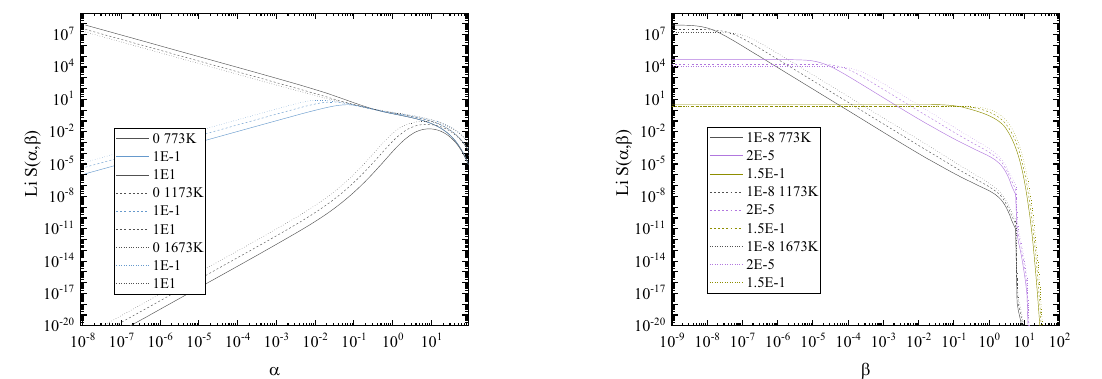
Figure 7 . TSL v. α (left, for various β values) and TSL v. β (right, for various α values) for Li in FLiBe at 773 K, 1173 K, and 1673 K.